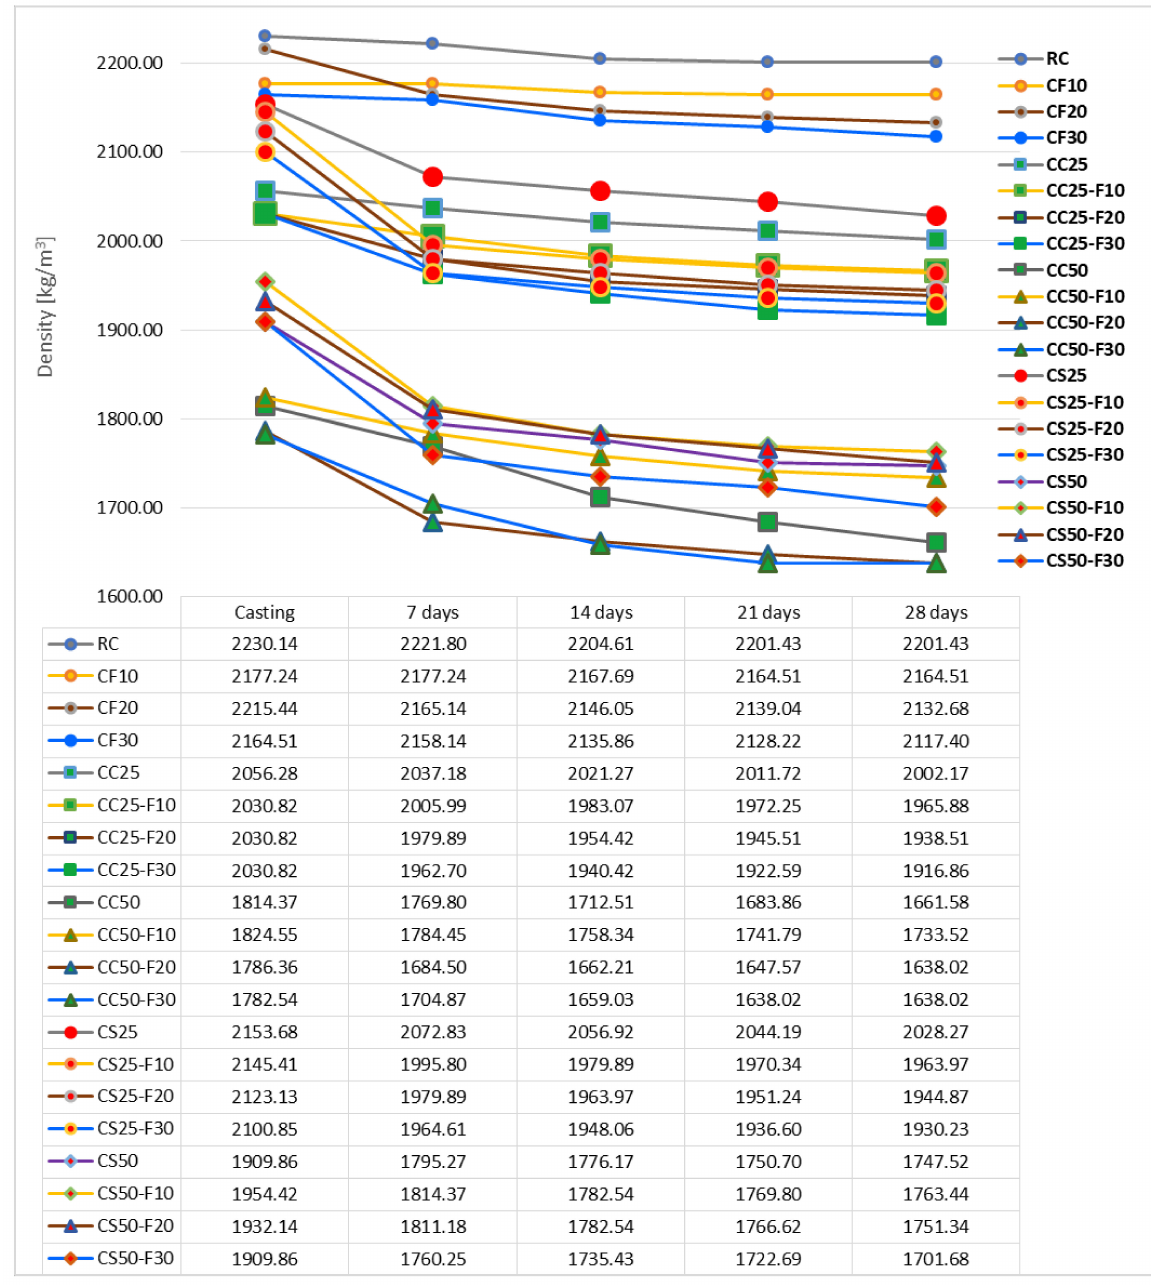
Figure 11. Density evolution of the composites with fly ash, corn cobs, sunflower stalks during the 28 days of curing [kg/m 3